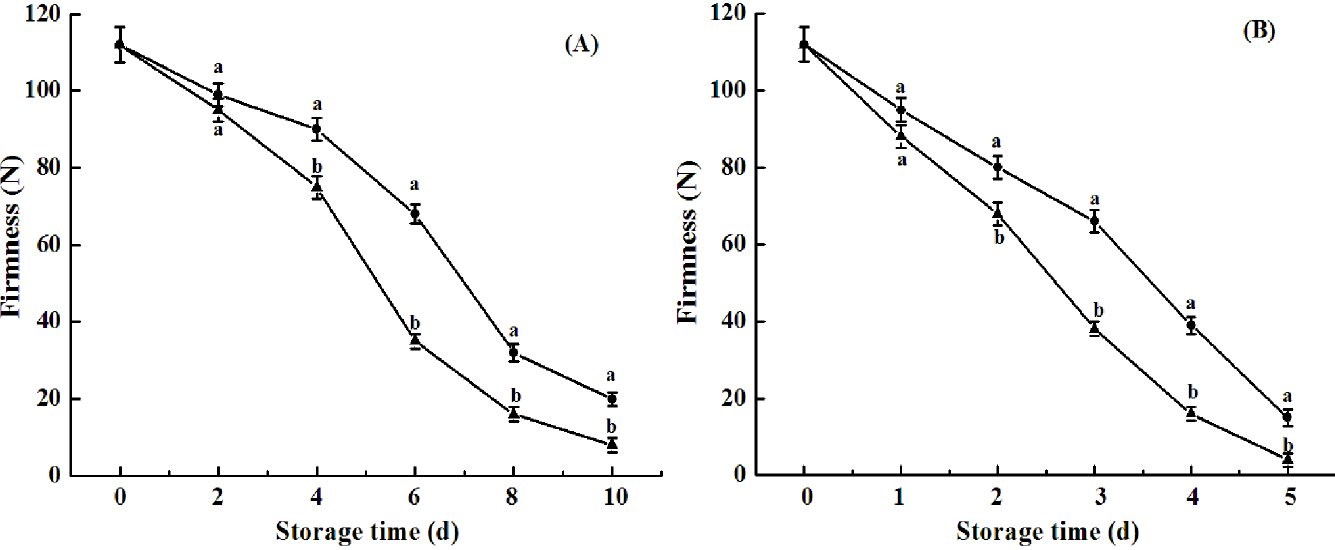
Fig 4. Firmness of avocado fruits upon natural (A) or ethylene-induced (B) ripening with ( ● ) or without ( ▲ ) cold shock treatment (CST) during 10- or 5-day storage at 20˚C and 85–90%RH. Vertical bars represent the standarderror of three replicates. Different letters at any storage time indicate significantdifferences (P < 0.05).